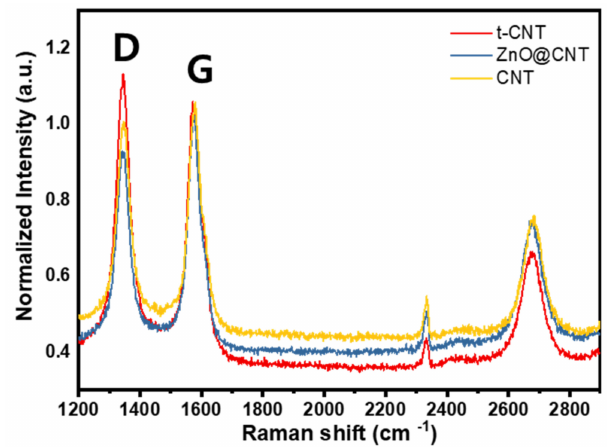
Figure 4. Raman data of comparison between t-CNT, ZnO@CNT, and